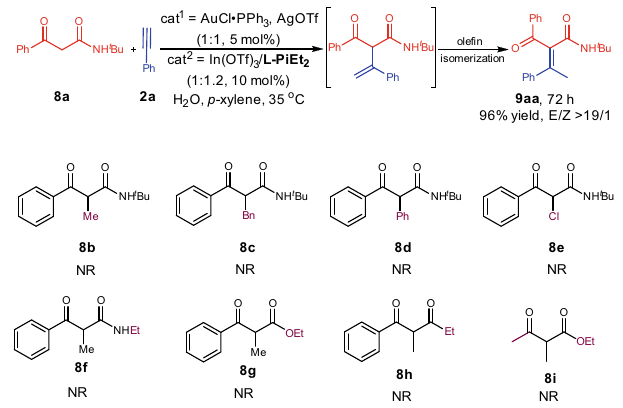
Fig. 4 Substrate scope limitation of α -substituted acyclic β -ketoamides. Unless otherwise noted, all reactions were carried out, AuCl ∙ PPh 3 /AgOTf (1:1, 5 mol%), In(OTf) 3 / L-PiEt 2 (1:1.2, 10 mol%), 8 (0.10mmol) and 2a (3.0 equiv), H 2 O (2 μ L) as additive in p -xylene (1.5 mL) at 70 °C for 120